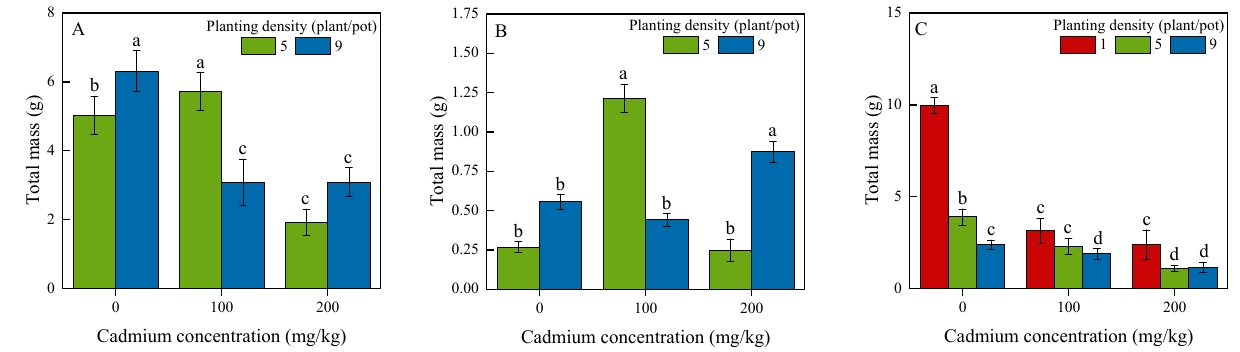
Figure 1. Total biomass of A. philoxeroides and T. regens subjected to cadmium concentration and planting density. ( A – C ) were the total biomass of A. philoxeroides in mixed culture, the total biomass of T. regens in mixed culture, and the total biomass of A. philoxeroides in monoculture, respectively. The data represents the means ± SE ( n = 5). Lowercase letters indicate a significant difference ( p < 0.05) in A. philoxeroides or T. regens present on each treatment based on post hoc multiple comparisons in Duncan with cadmium concentration and planting density as fixed factors.